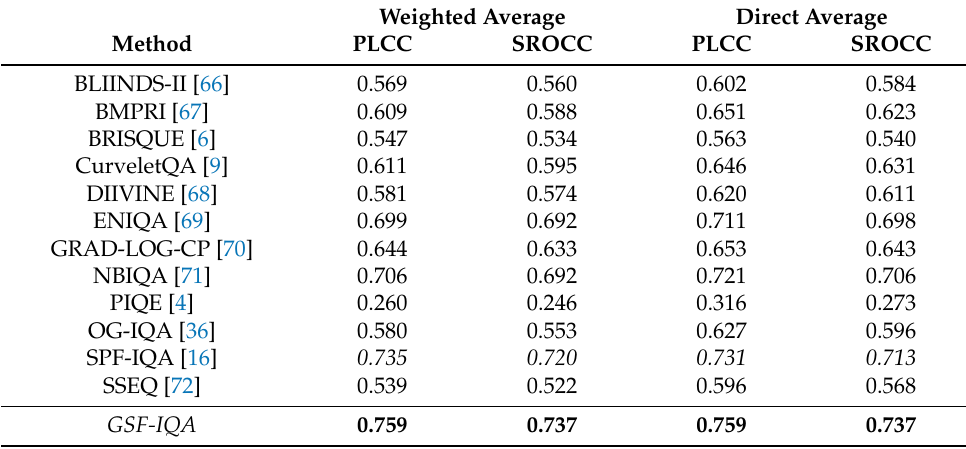
Table 8. Comparison of GSF-IQA to the state-of-the-art. Weighted and direct average of measured PLCC and SROCC values are reported. Best results are typed in bold, second best results are typed in